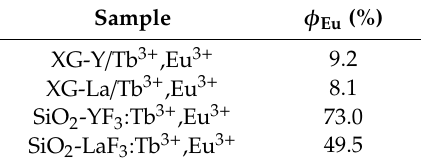
Table 4. Quantum yields ( φ Eu ) calculated for fabricated xerogels and glass-ceramic materials.